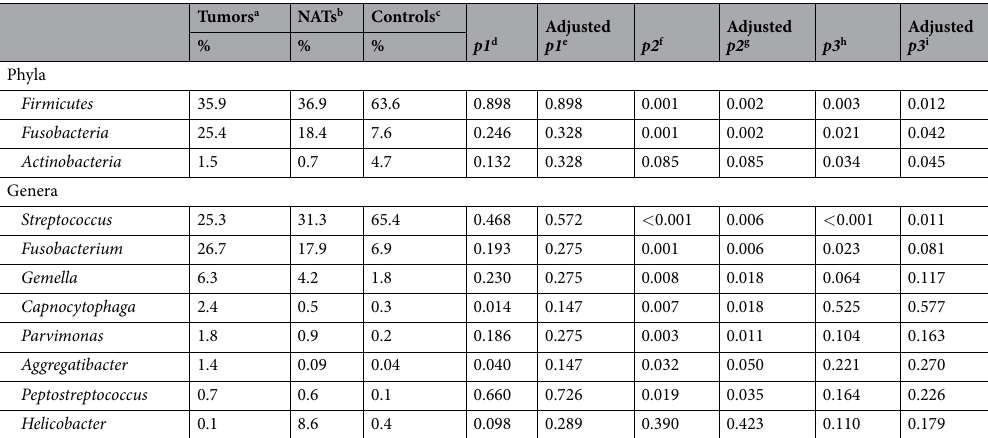
Tumors a NATs b Controls c